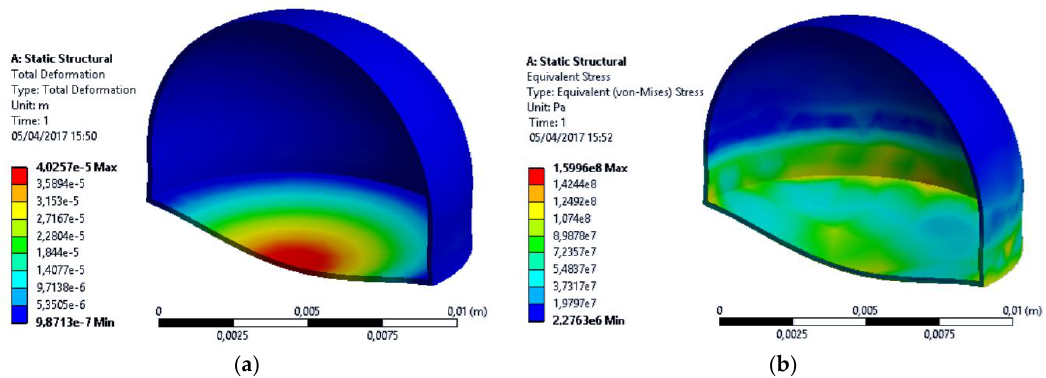
Figure 3. Simulation of 304 L stainless steel argon reservoir at 7 atm of pressure: ( a ) total deformation; ( b ) equivalent